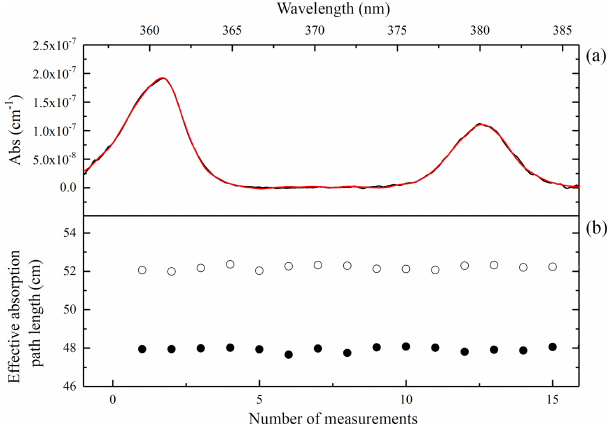
Figure 3. (a) Examples of concentration retrieval with O 2 -O 2 . Here, the black line is the measured spectrum and the red line is the fitted O 2 -O 2 absorption spectrum. (b) The black dots are the effective absorption path length with 0.1SLPM purge flows and 1SLPM sampling flow, and the circles are the effective absorption path length with 0.1SLPM purge flows and 3SLPM sampling